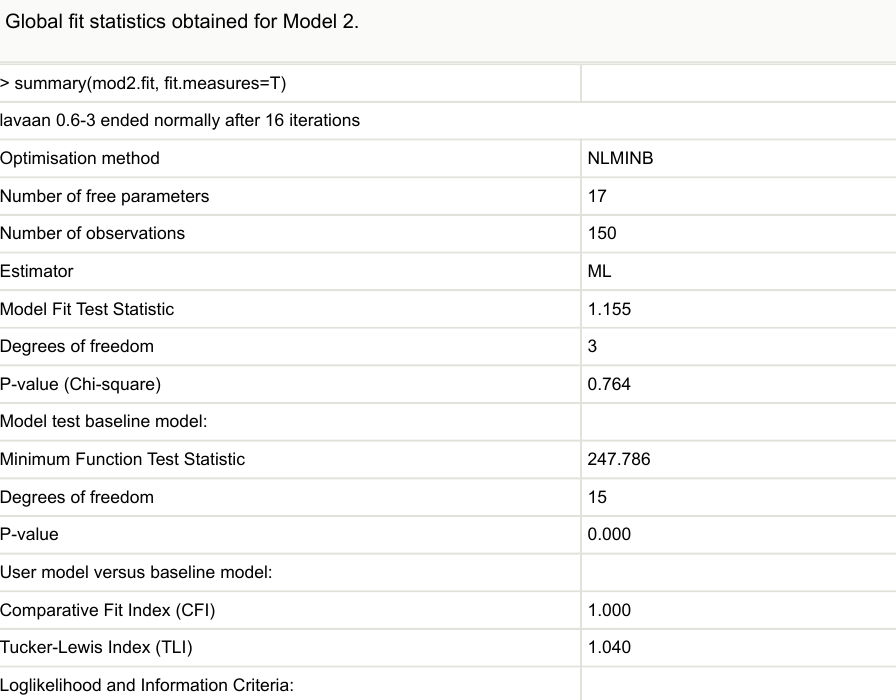
Global fit statistics obtained for Model